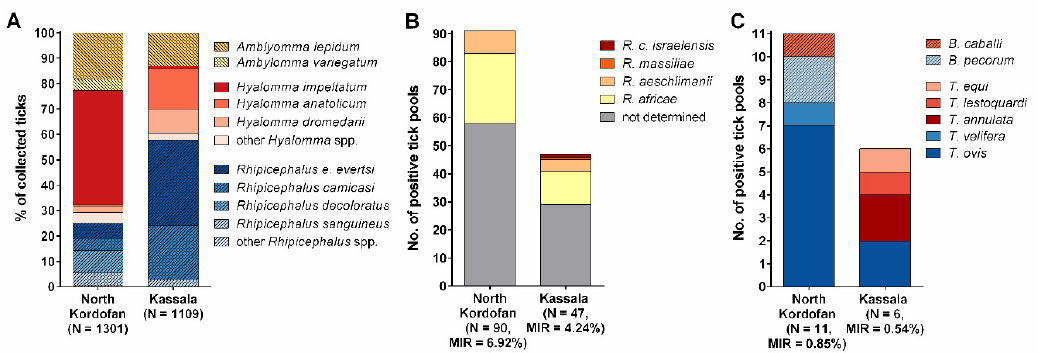
Figure 2. Species composition of ticks and tick-borne pathogens detected in North Kordofan and Kassala, Sudan. ( A ) Species composition of ticks collected from livestock and other domestic animals from January to August 2017. ( B ) Rickettsia species composition among pan- Rickettsia real-time PCR-positive tick pools. ( C ) Piroplasm species composition among PCR-positive tick pools. Pathogenic species are indicated in shades of red, while apathogenic species are shown in shades of blue. MIR = minimum infection rate.